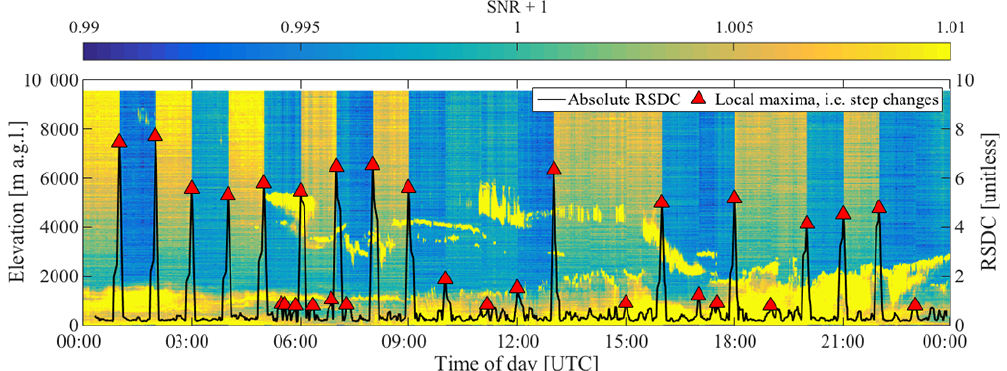
Figure 6. Time–height plot of uncorrected SNR from a Halo Doppler lidar operating at Hyytiälä, Finland, on 21 May 2014, together with the calculated absolute RSDC at wavelet decomposition level 5 (line), and the detected local maxima i.e. step changes (triangles).